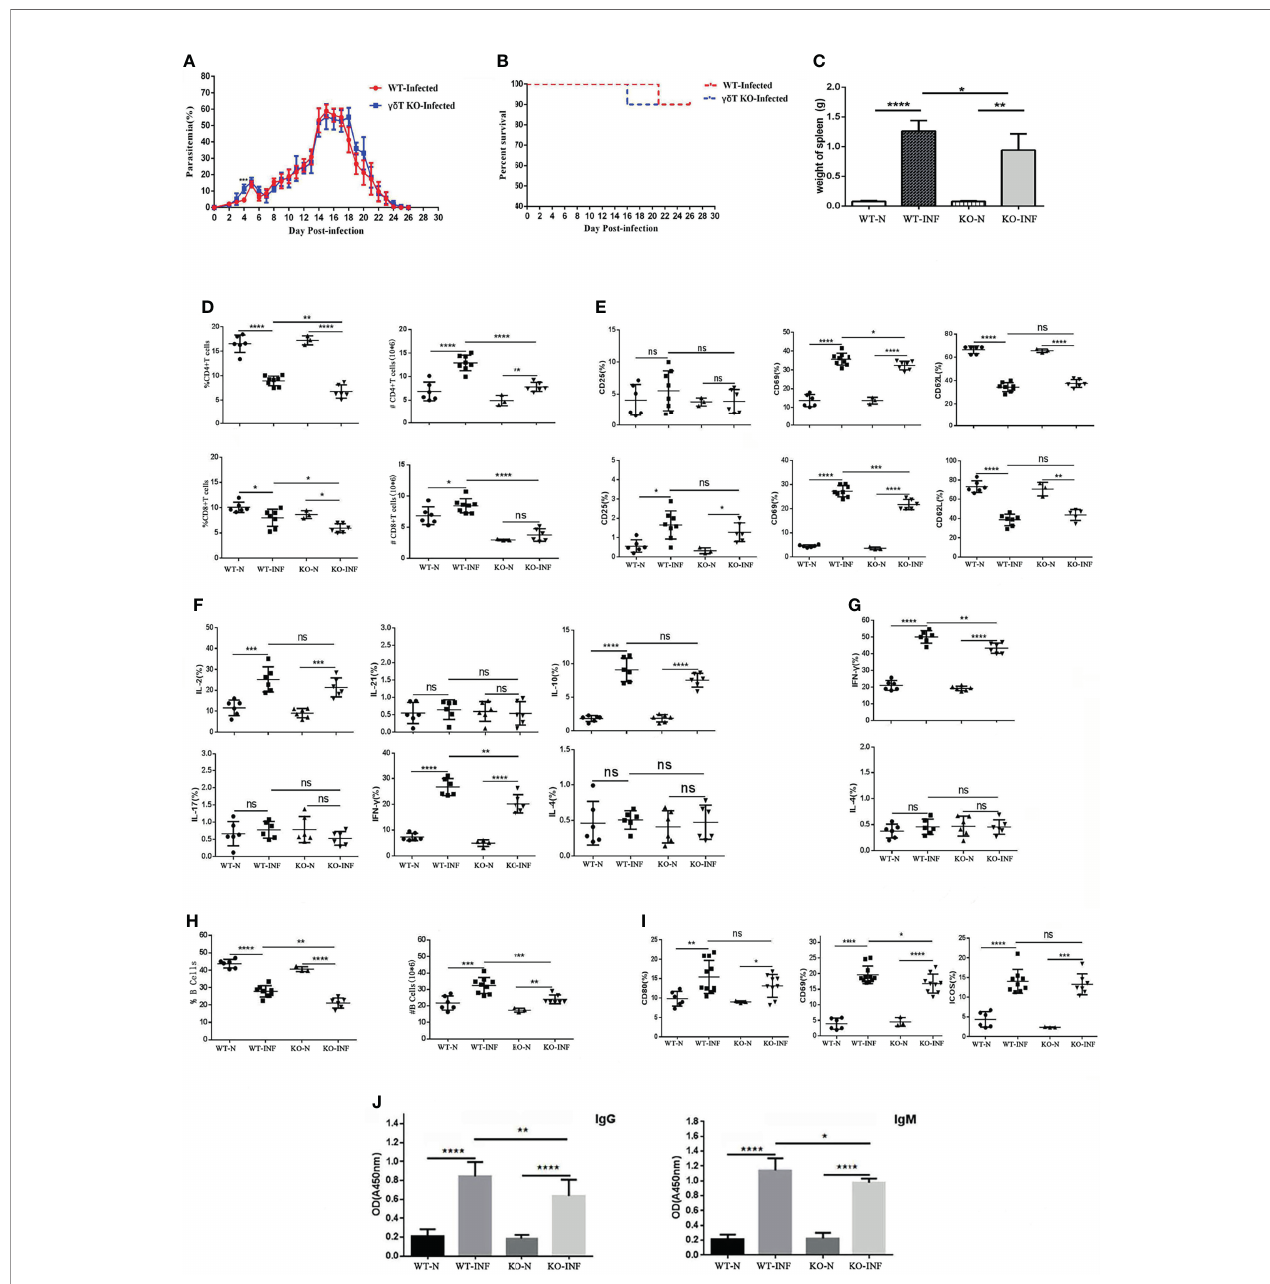
FIGURE 4 | gd TCR KO decreased splenic T cell response and B cell response in P. yoelii NSM infected mice. Dynamic monitoring of percent parasitaemia (A) and percent survival (B) in wild-type C57BL/6 and gd TCR KO mice, which were both infected with Plasmodium yoelii NSM . * P <0.05. Representative results of two independent results are shown (N=10). (C) Mice were infected with P. yoelii NSM, and 14 days later, spleens were separated from both naive and P. yoelii NSM infected wild-type and KO mice. The weights of the spleens from each group of mice were measured (N=5-6). (D) FCM statistical graphs of the distribution and content of splenic CD4 + T cells and CD8 + T cells in the two infected and two naive groups. # refers to absolute number. (E) The expression levels of CD69, CD62L and CD25 on CD4 + T cells and CD8 + T cells in P. yoelii NSM infected mice compared with the two naive groups. (F, G) The cytokine expression levels of IFN- g , IL-2, IL-4, IL-10, IL-17, and IL-21 in CD4 + T cells and CD8 + T cells obtained from Plasmodium -infected mice compared with the two naive groups. (H) The percentage and content of B cells in each group of mice were detected by FCM and counted. (I) The expression levels of CD69, ICOS and CD80 in B cells in each group of mice were detected by FCM. (J) Serum from both naive and infected C57BL/6 and gd TCR KO mice was collected and diluted 100 times. The contents of malaria-speci fi c IgM and IgG antibodies were detected by ELISA. The OD values are shown. Representative results of three independent results are shown (N=5) and the error bars are SD. **** P < 0.0001, *** P < 0.001, ** P < 0.01, * P < 0.05, ns, P >